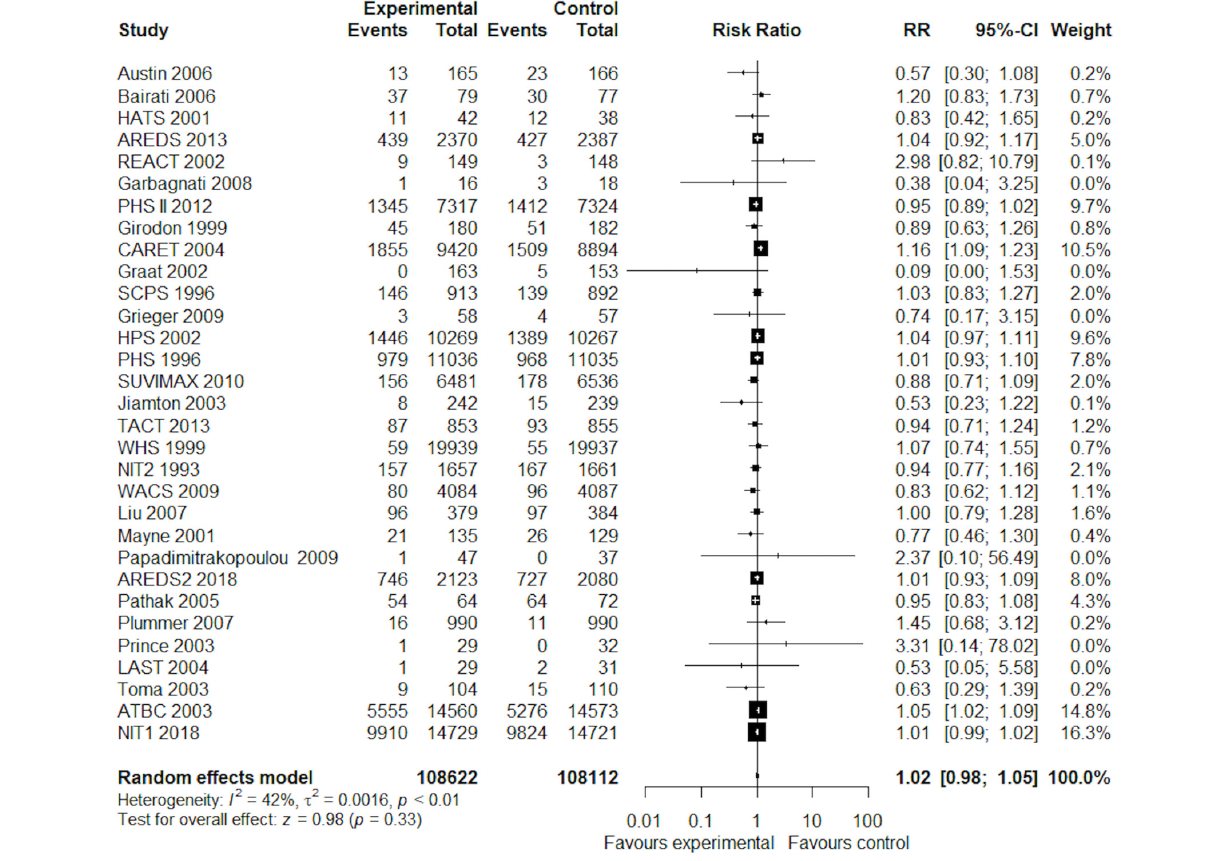
FIGURE 2 | Forest plot showing the effect of beta-carotene supplementation on total mortality in 31 randomized controlled